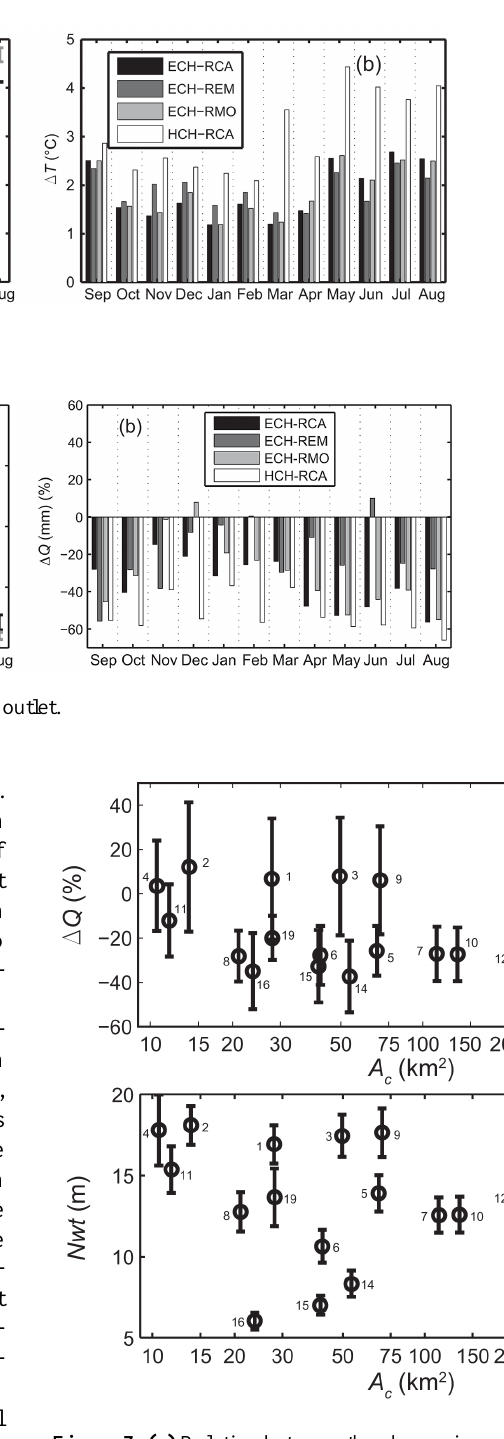
Figure 7. (a) Relation between the change in annual runoff, (cid:49)Q , and sub-basin contributing area, A c . (b) Relation between the mean level of the groundwater table, Nwt , in the FUT period and A c . Bars represent mean ± standard deviation across the CMs. The number of each sub-basin as reported in Fig. 2b and Table 3 is also